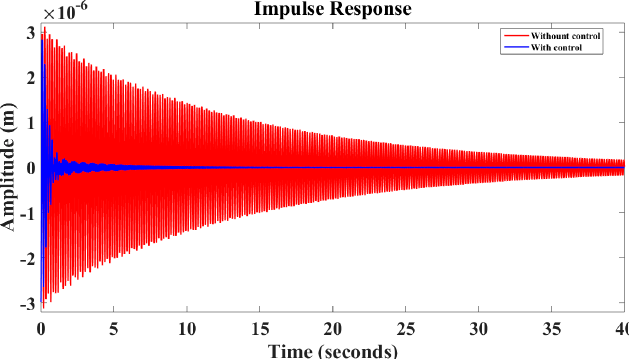
Figure 8. Impulse response of the beam (Sensors in FE2, Q = 10 13 , R = 1, Gc = 100).